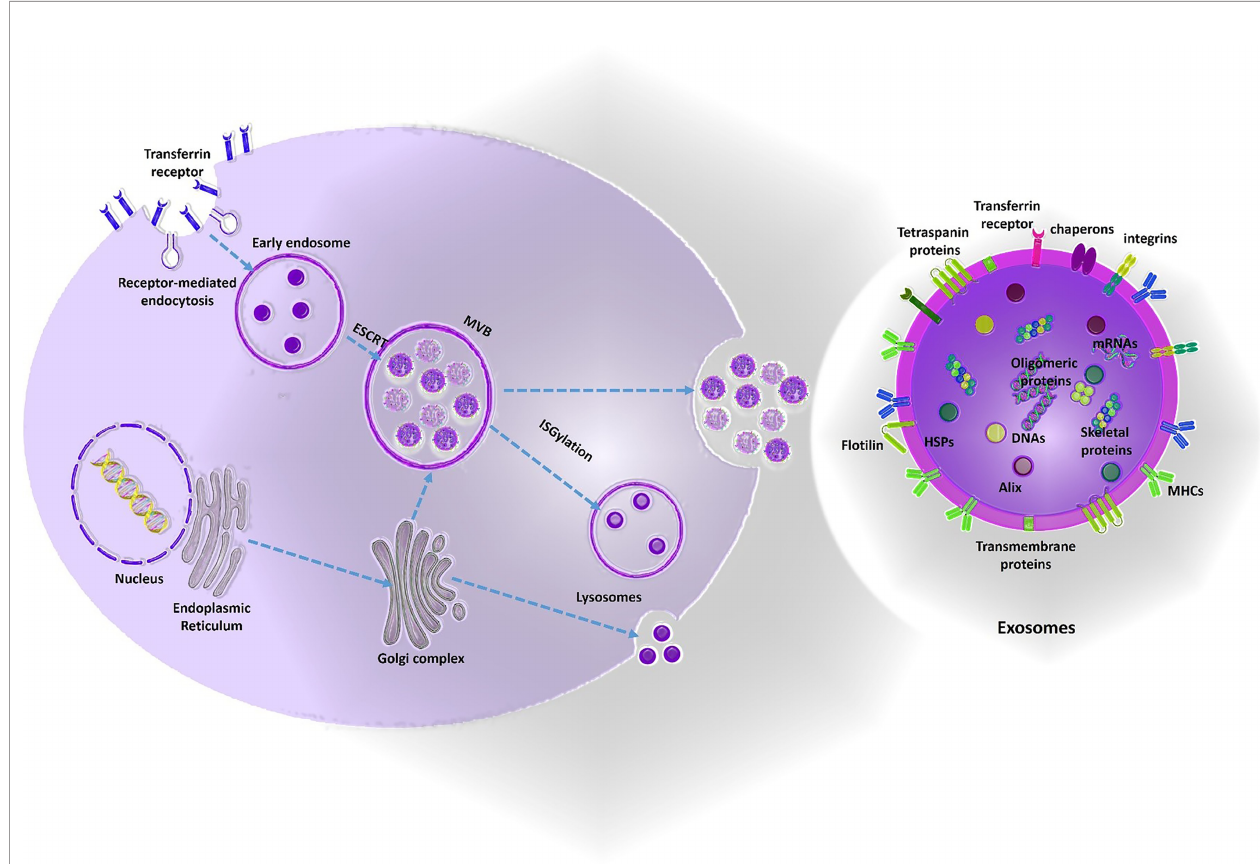
FIGURE 5 | Exosomes biogenesis. Mainly, exosomes are produced by ESCRT- dependent mechanisms from early endosomes into the multivesicular bodies (MVBs). Exosomes contain the members of tetraspanin protein family and ESCRT proteins and their accessory proteins as positive markers for EV characterization. Moreover, exosomes also contain signaling cargos which mediate paracrine interaction of cells (DNAs, proteins, and also RNAs). Exomes are potent engineerable biological nano-carriers which pass through the BBB and can be used as a trojan horse to deliver the drugs to the brain. Some of the vectors used to design this fi gure were downloaded from Vecteezy under a free